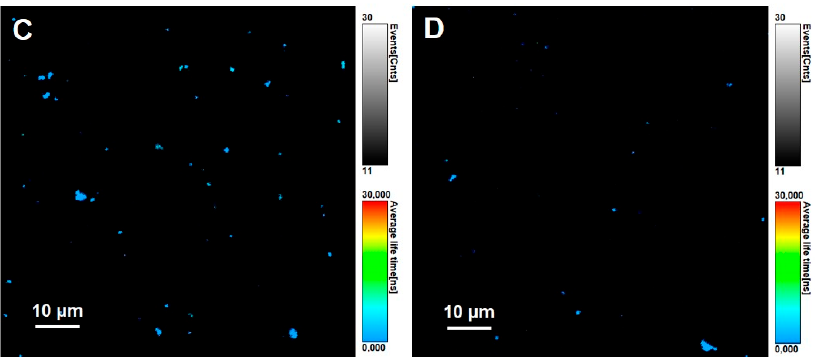
Figure 4. Fast lifetime imaging microscopy (FLIM) image of a 4 ′ ,6-diamidino-2-phenylindole (DAPI)-stained E. coli cell ( A ), of a bacteria treated gold substrate ( B ), bacteria treated gold substrate with porphyrin 12 ( C ) and porphyrin 11 ( D ).